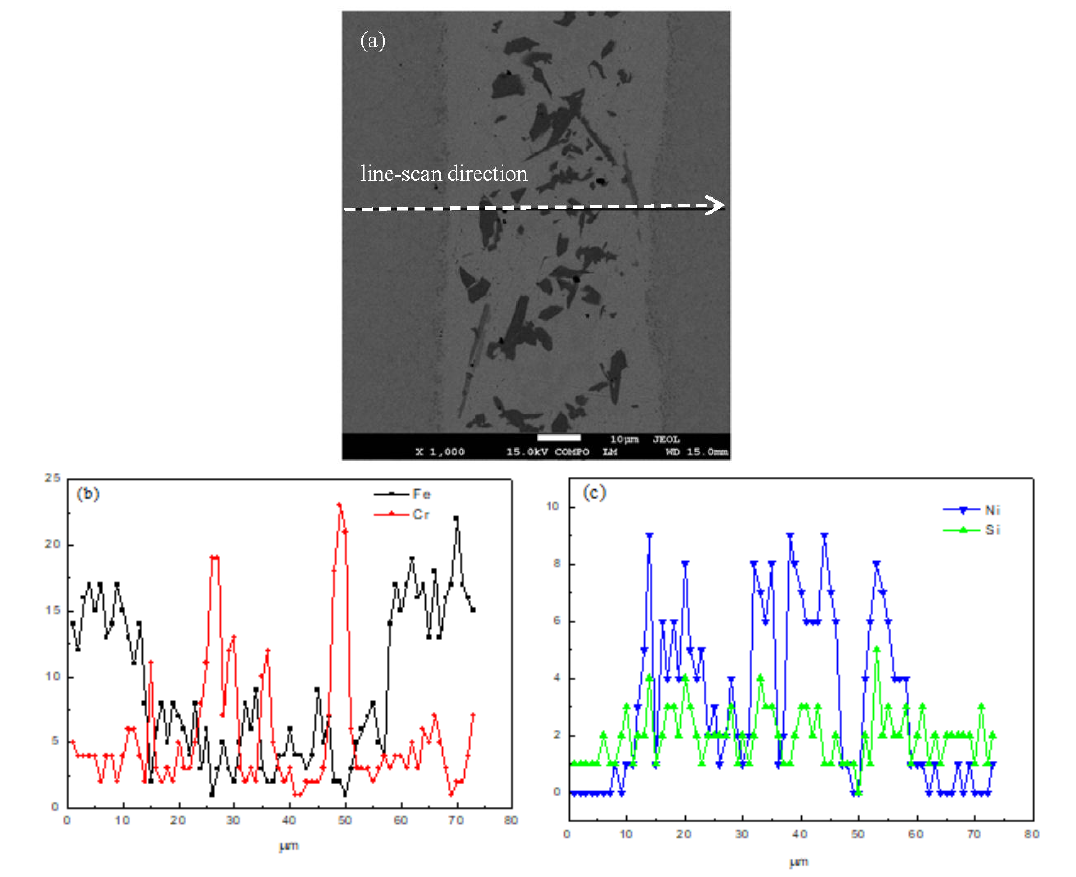
Figure 4. Line-scan analysis of the joint brazed at 1120 °C for 10 s, ( a ) line-scan direction, ( b ) content of Fe and Cr, ( c ) content of Ni and Si.